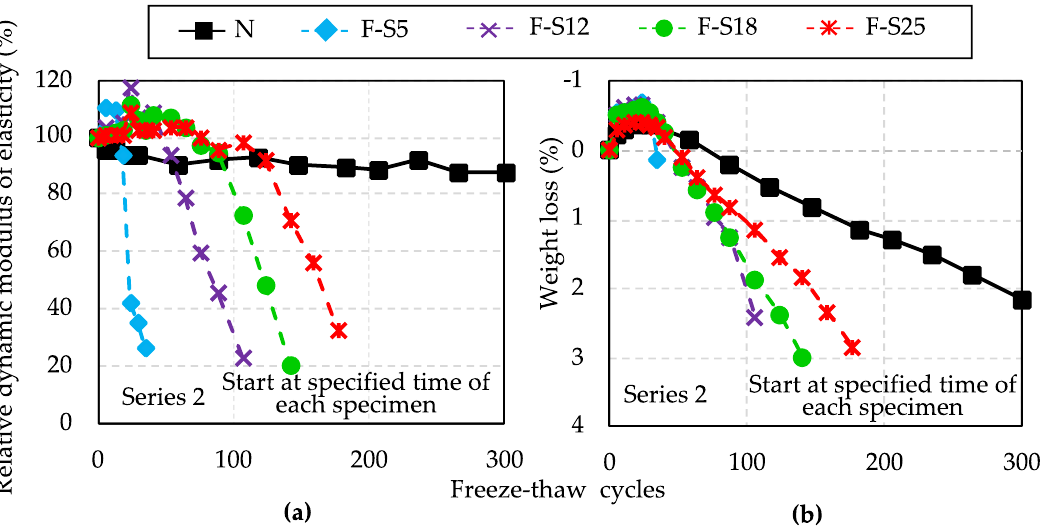
Figure 9. Results of relative dynamic modulus of elasticity ( a ) and weight loss ( b ) after 300 freeze–